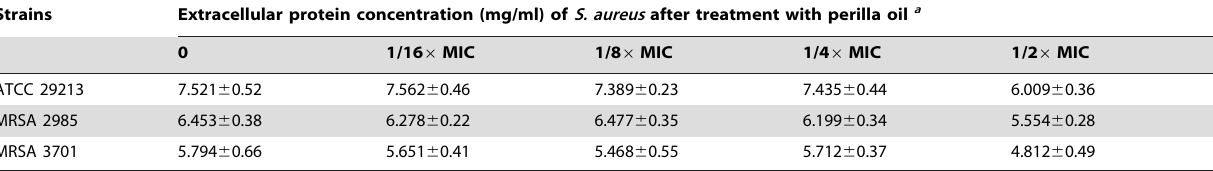
Strains Extracellular protein concentration (mg/ml) of S.aureus after treatment with perilla oil a